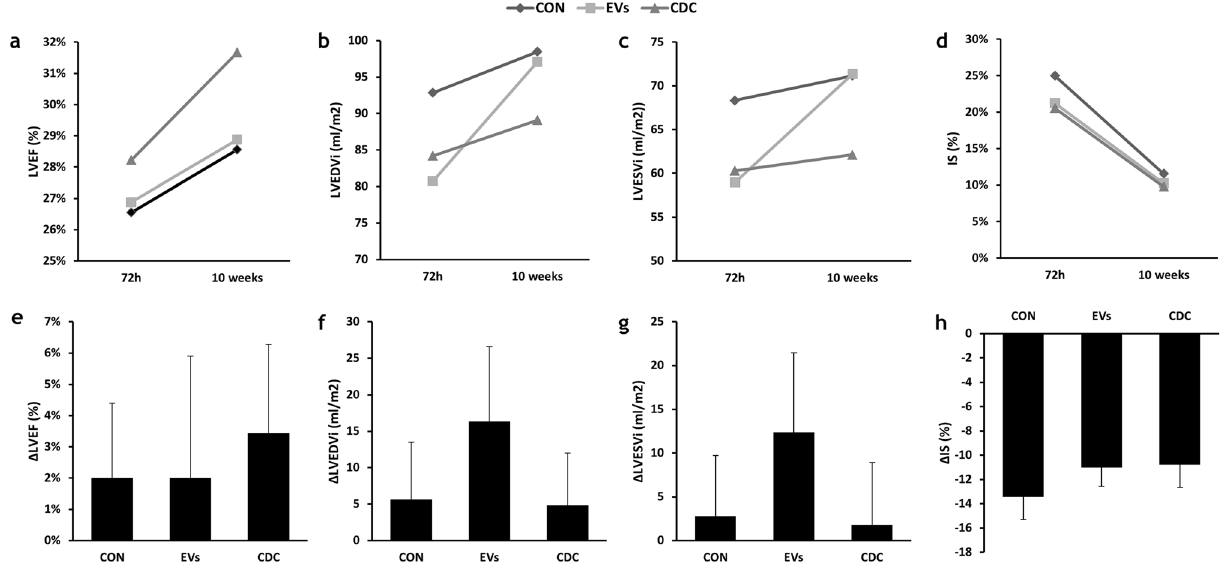
Figure 4. Evolution of cardiac function parameters after intrapericardial CDC, EV or Control administration in infarcted swine. ( a – d ) Changes over time in cardiac function parameters as measured with cardiac magnetic resonance (CMR) for the three experimental groups (CON, EV and CDC). ( a ) Evolution of left ventricular ejection fraction (LVEF). ( b ) End diastolic volume indexed to body surface area (EDVi). ( c ) End systolic volume indexed to body surface area (ESVi). ( d ) Evolution of infarct size. ( e – h ) Treatment effects (defined as the difference between pre-injection and 10-week values). ( e ) Effects on left ventricular ejection fraction (LVEF). ( f )